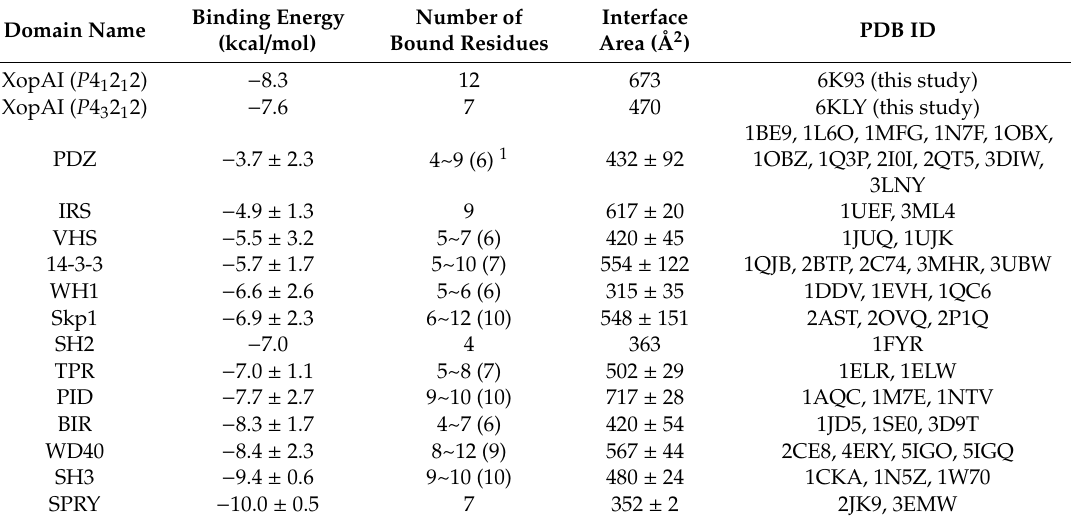
Table 3. The predicted binding energy between known peptide-binding domains and their